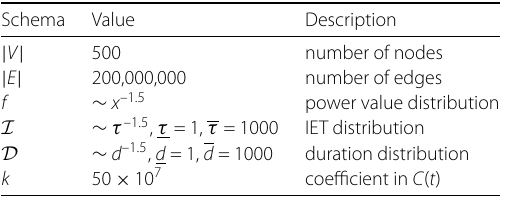
Table 4 The default configuration for the scalability